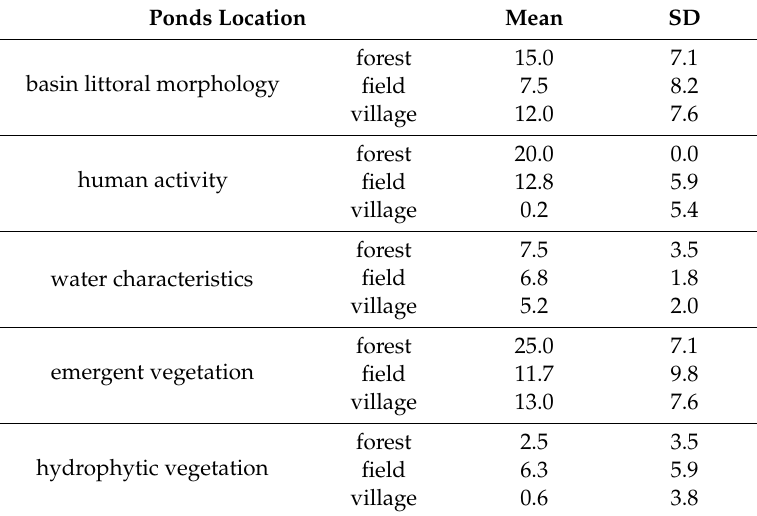
Table 2. The value of ECELS components for ponds according to land use.